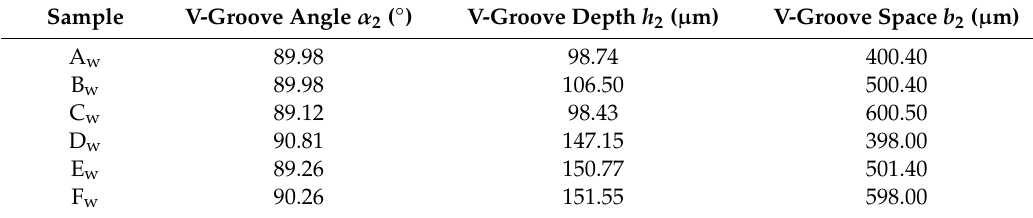
Figure 8. The profiles of micro-structured polymers: (a) Sample A w ; (b) Sample B w ; (c) Sample C w ; (d) Sample D w ; (e) Sample E w ; (f) Sample F w . Table 5. The V-grooved structure parameters of micro-structured